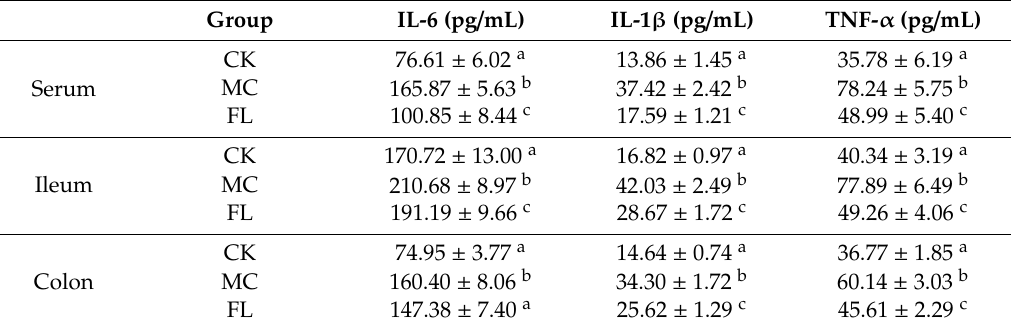
Data are expressed as mean ± SD (n = 8). Values in the same column labeled with different superscripts (a–c) differ significantly ( p < 0.05). Interleukin-6, IL-6; tumor necrosis factor- α , TNF- α ; iInterleukin-1 β , IL-1 β .